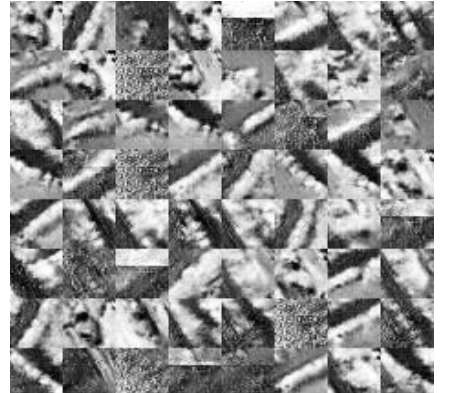
Figure 4.Example of generating 64 virtual training samples by GAN in class #4 in Pavia University Dataset (Tree)